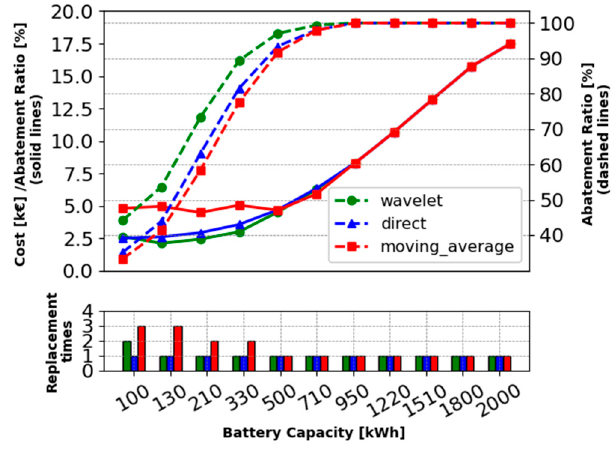
Figure 23. Upper chart: comparison of AR capabilities and specific cost of the different methods considered. Lower chart: battery replacement times.